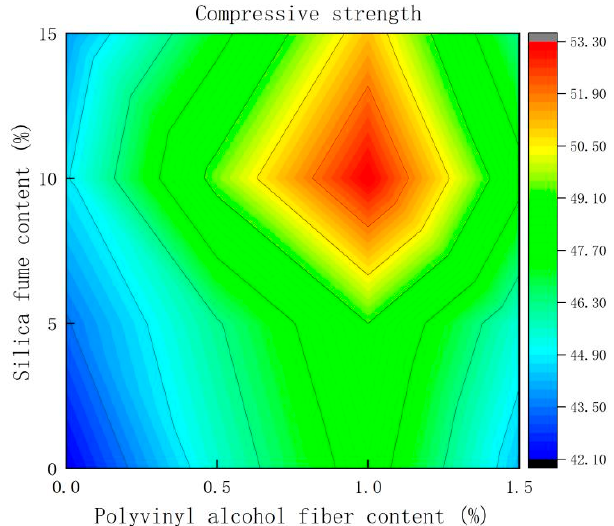
Figure 3. Contour map of compressive strength.